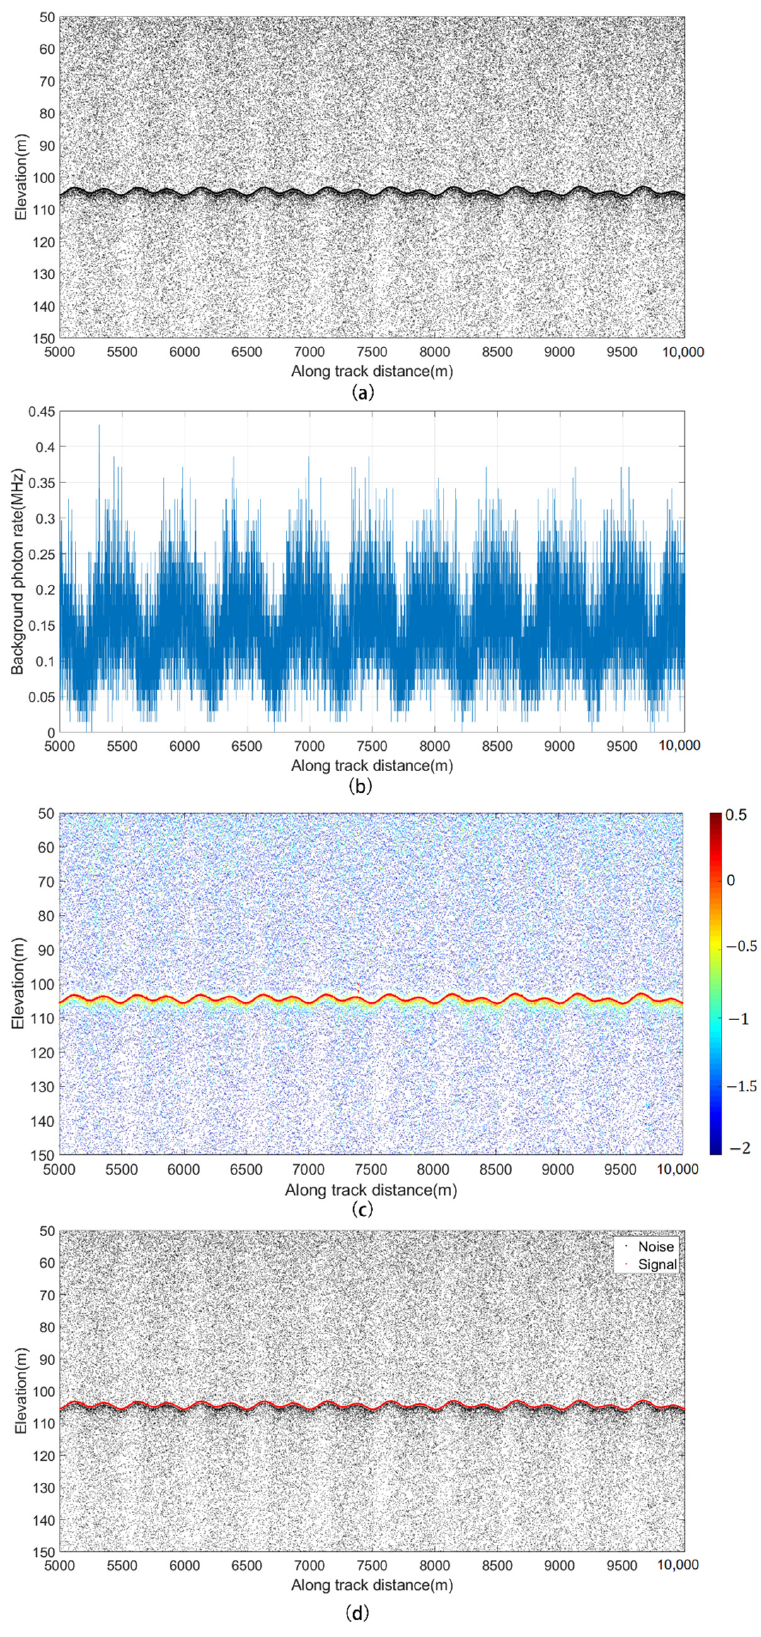
Figure 13. ( a ) Original homemade LiDAR data. ( b ) Background photon counts rate. ( c ) Threshold minus the KNN distance of query points. ( d ) Denoised results.